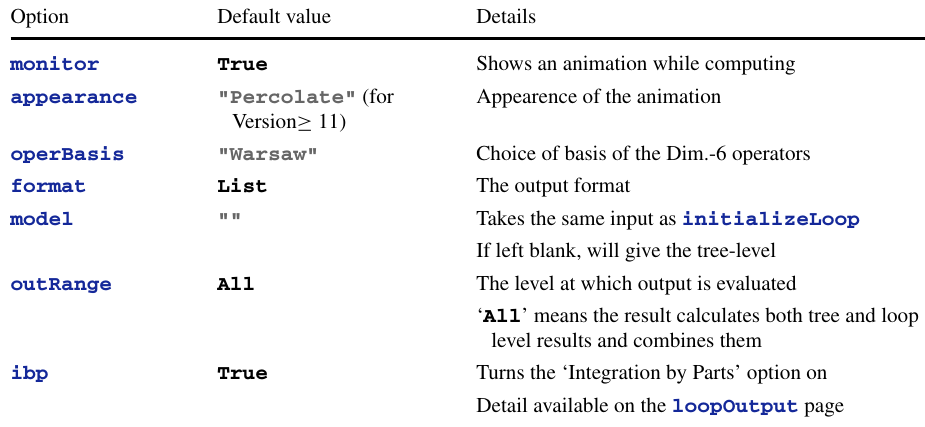
Table 5 The Options for codexOutput . Other than these, this function also takes all Options of formPick